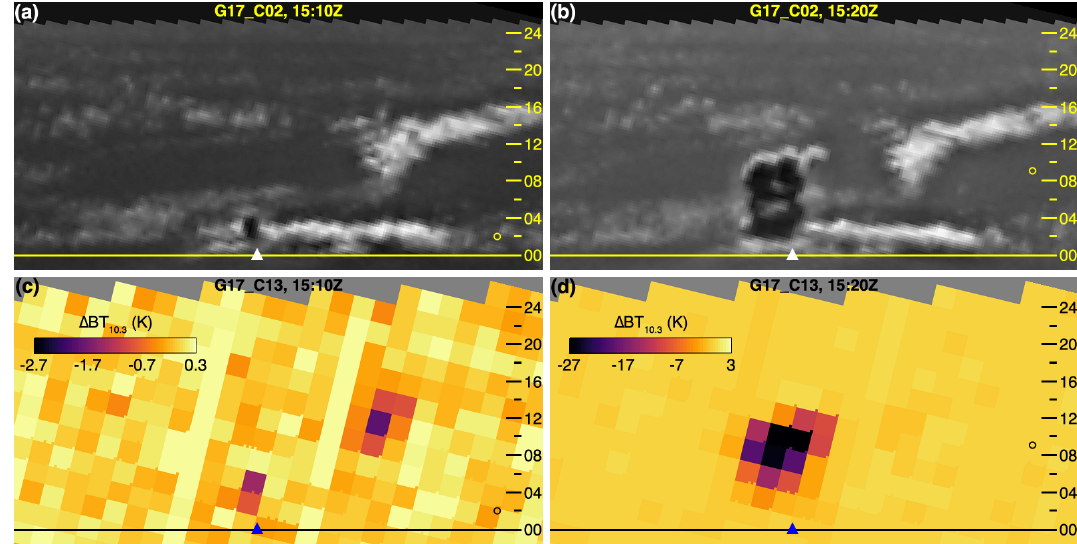
Figure 13. The eruption plume on 22 April 2021 at (a, c) 15:10UTC and (b, d) 15:20UTC in GOES-17 imagery: (a, b) channel 2 and (c, d) channel 13 running difference, with elevation markings as in Fig.